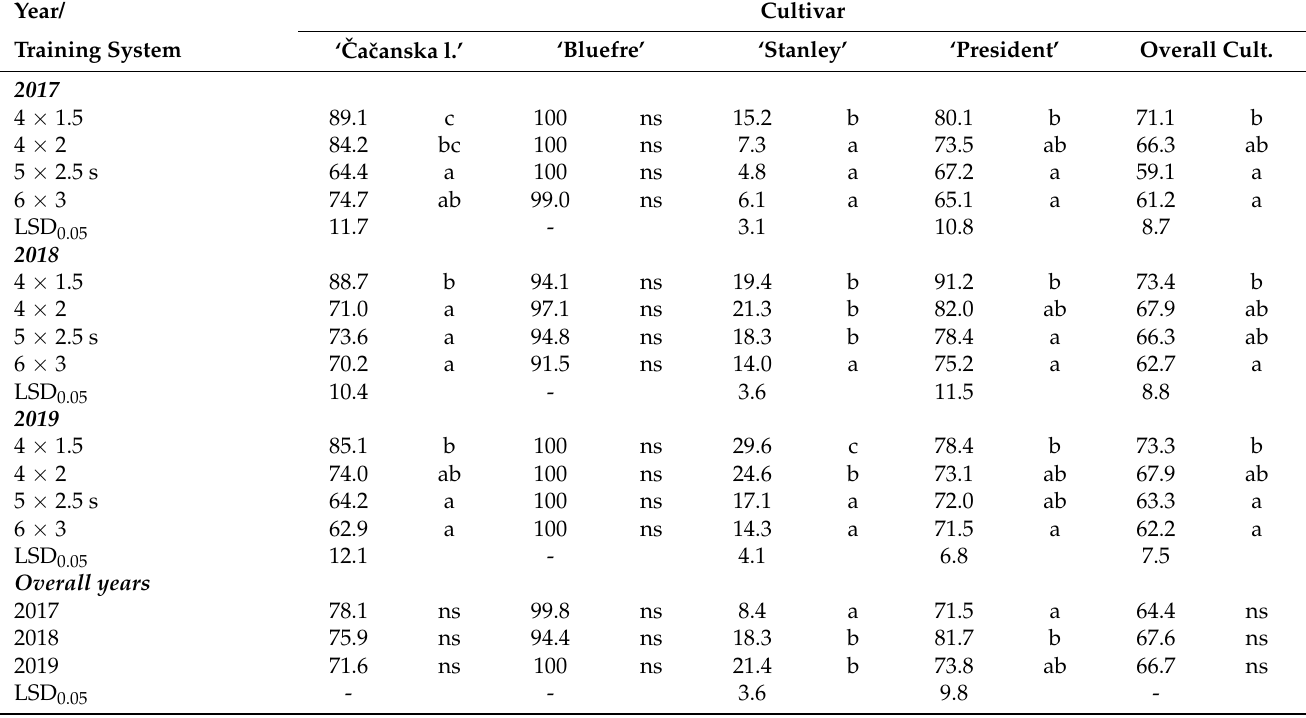
Table 5. The effects of years (2017, 2018 and 2019); training systems (4 × 1.5, 4 × 2, 5 × 2.5 and 6 × 3 m); and cultivars (‘ ˇCaˇcanska lepotica’, ‘Bluefre’, ‘Stanley’ and ‘President’) on final disease incidence ( Y f ) of shot hole disease in an integrated plum orchard at Debrecen-Pallag, East Hungary. Values within the given cultivar coupled with different letters are significantly different among each training system at p = 0.05 according to LSD t -tests; ns: